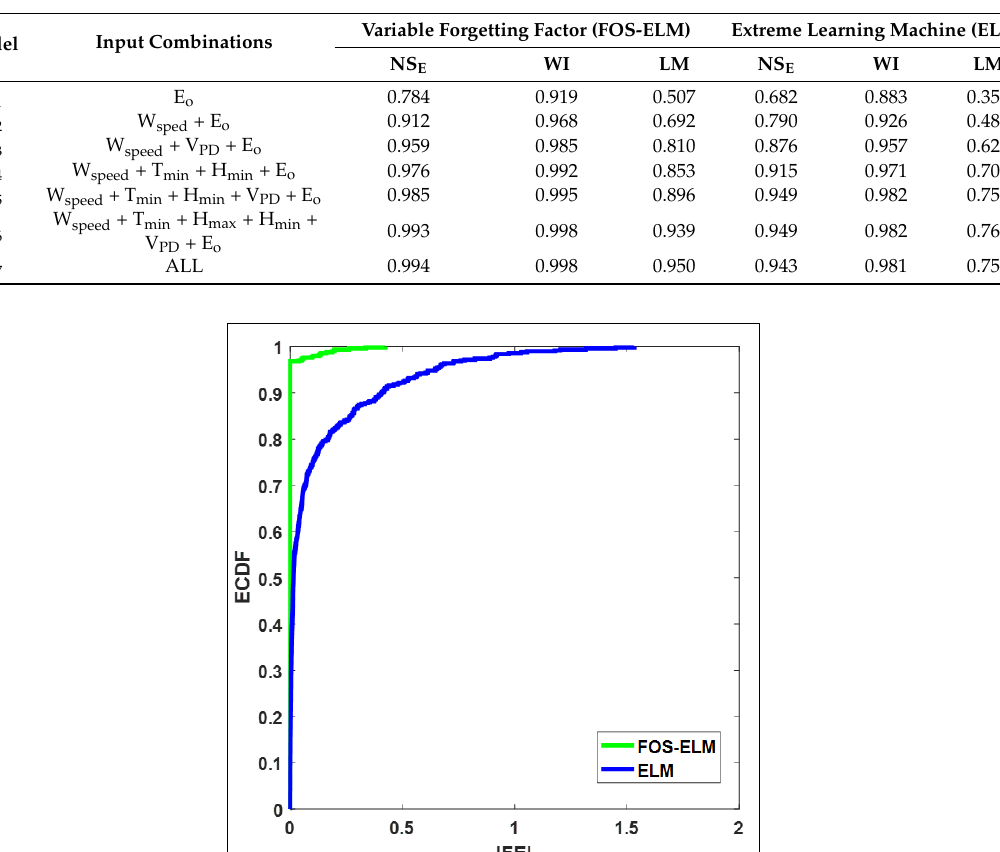
Table 3. Numerical comparison between FOS-ELM and ELM models based ( RRMSE , %) and the ( RMAE , %) computed within the test sites. Note that the best model is boldfaced.